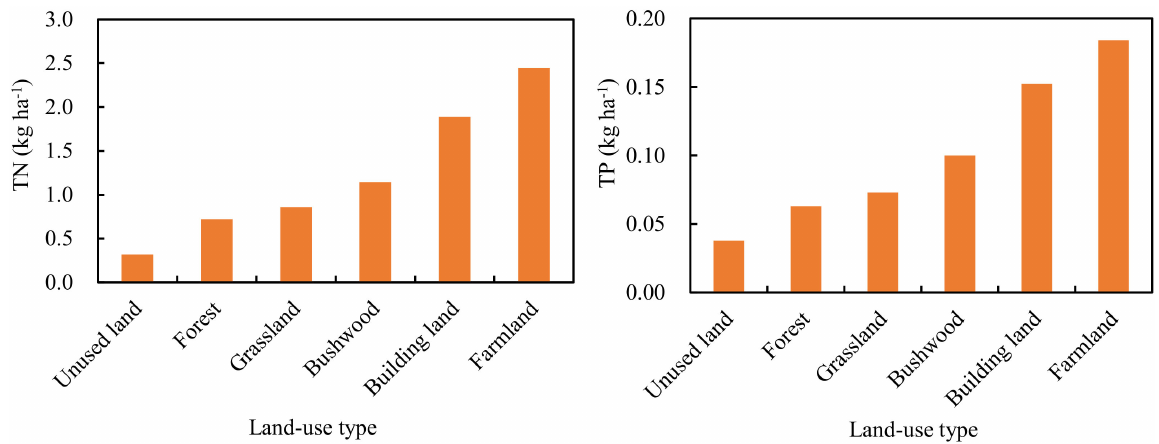
Figure 9. Pollution load intensity of different land use types in Lake Erhai